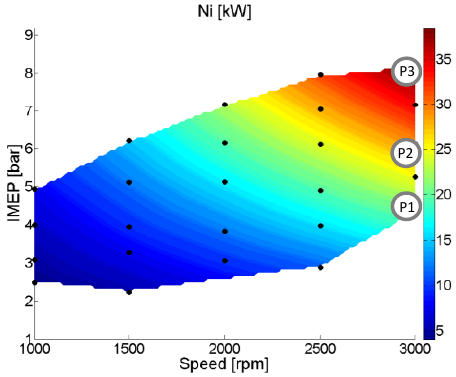
Figure 10. Indicated power in the RCCI portion of the map. The three selected points to perform the parametric study are marked in the map.